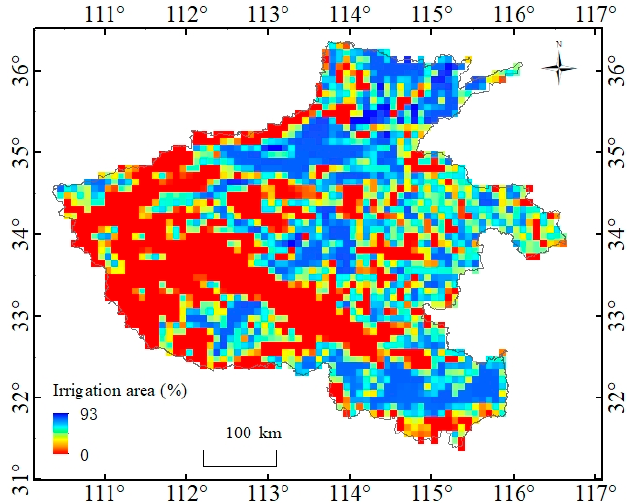
Figure 9. Distribution map of irrigated extent and irrigation area in Henan Province (ORNL DAAC. 2017).